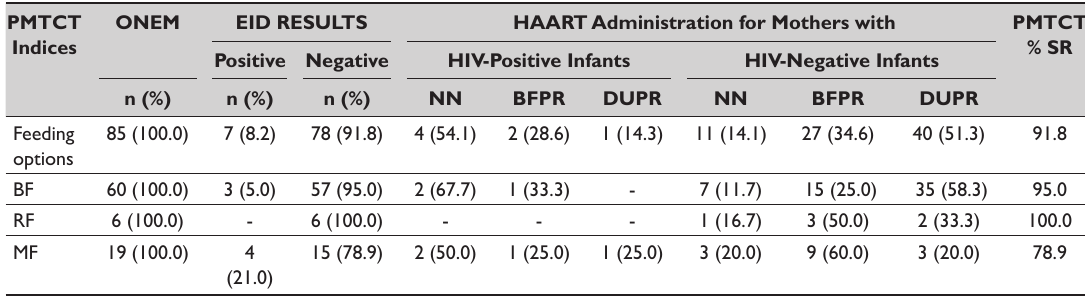
Table 3: PMTCT success rate among enrolled patients based on antiretroviral therapy interventions and feeding options PMTCT ONEM Indices